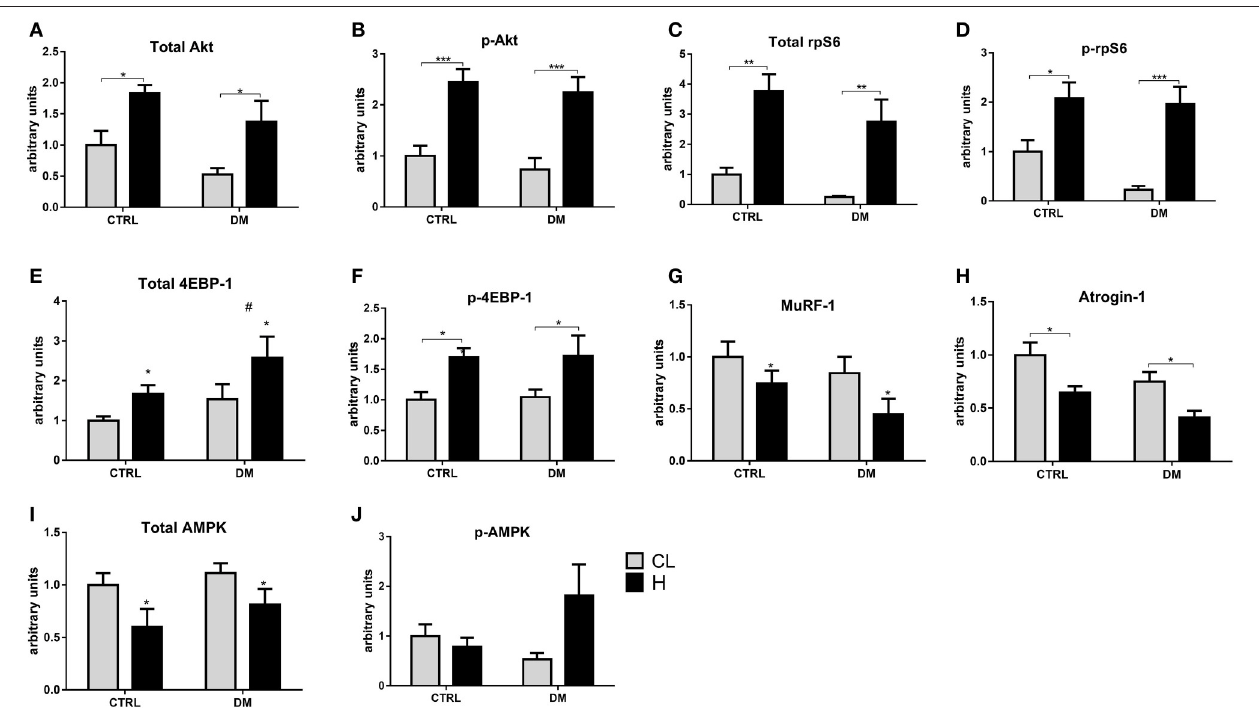
FIGURE 5 | (A–D, F,H,J) Contents of signaling proteins associated with protein synthesis and degradation in the soleus muscle after 7 days of overload. Quantitative analysis of western blotting of total and phosphorylated Akt, rpS6, AMPK, MuRF-1 and atrogin-1 of the soleus muscle. Data are expressed as mean ± SEM of at least six animals. * p < 0.05, ** p < 0.01, *** p < 0.001 using two-way ANOVA followed by Bonferroni post-test. In (E) , # p < 0.05 for CTRL vs. DM and * p < 0.05 for CTRL-CL/DM-CL vs. CTRL-H/DM-H, in (G) , * p < 0.05 for CTRL-CL/DM-CL vs. CTRL-H/DM-H, in (I) , * p < 0.05 for CTRL-CL/DM-CL vs. CTRL-H/DM-H